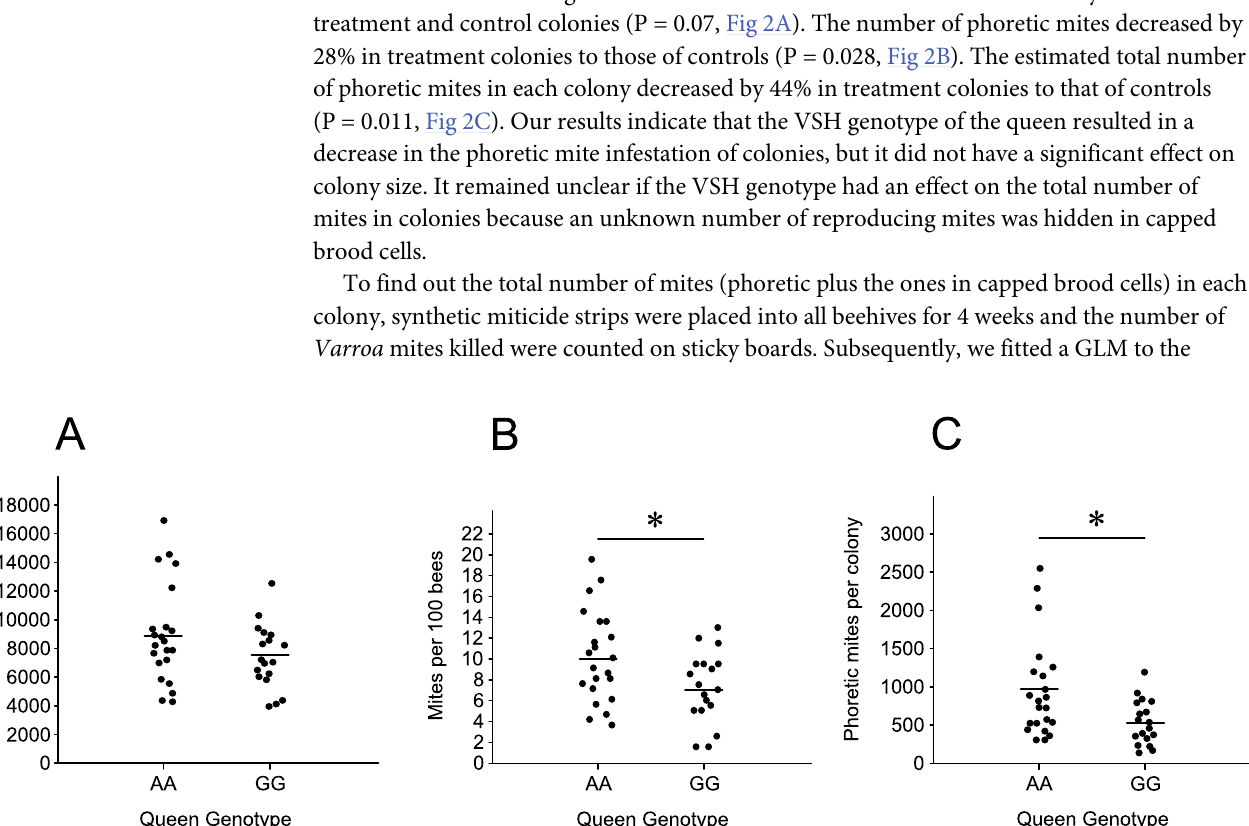
PLOS ONE | https://doi.org/10.1371/journal.pone.0273289 September 16,